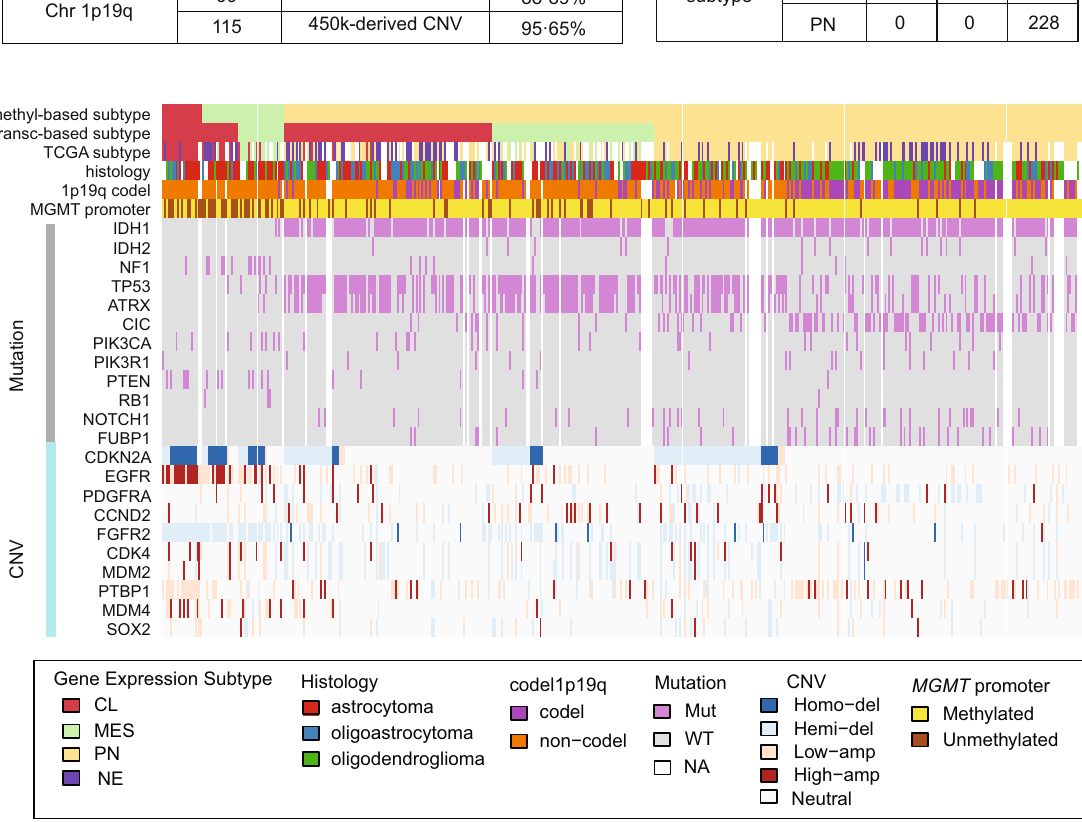
Probe selection . For genetic alterations within the binary classes, including IDH, TERT p, and ATRX mutation, and chr1p19 codel, raw data (IDAT fi les) of in fi l- (Fig. 5A). After quality control and probe fi ltering, one LGG sample did not pass the sample quality control and was excluded from the data set. After probe fi ltering, the fi nal data set included 644 gliomas samples with 380010 probes. Among the